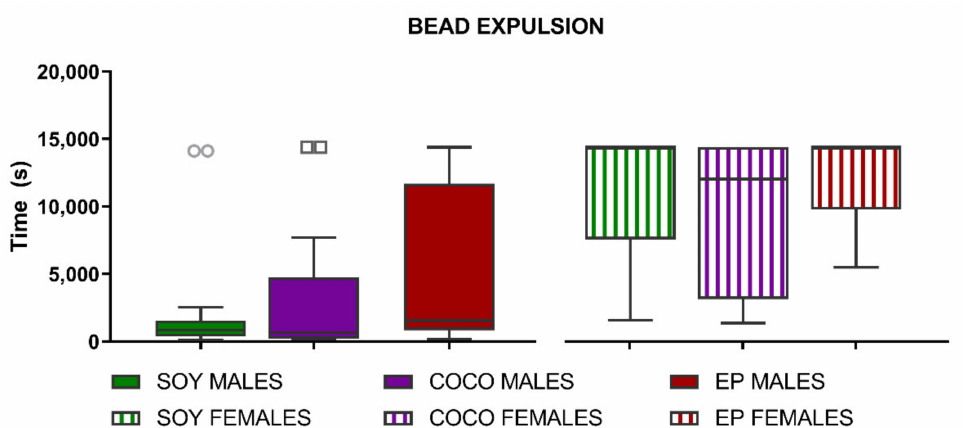
Figure 9. Effects of diet intervention on colonic bead expulsion in the rat. Male and female rats were exposed to AIN-93G diet containing 7% of soybean oil (SOY), or to modified AIN-93G diet containing 3.5% of soybean oil supplemented with 3.5% of coconut oil (COCO) or with 3.5% of evening primrose oil (EP). Colonic propulsion was measured as latency time after bead insertion, with a cut-off time of 14,400 s. Data were analyzed in males and females separately. Data are presented as median ± IQR ( n = 6–8 animals per group). Kruskal–Wallis test was performed followed by Dunn ´ s multiple comparison